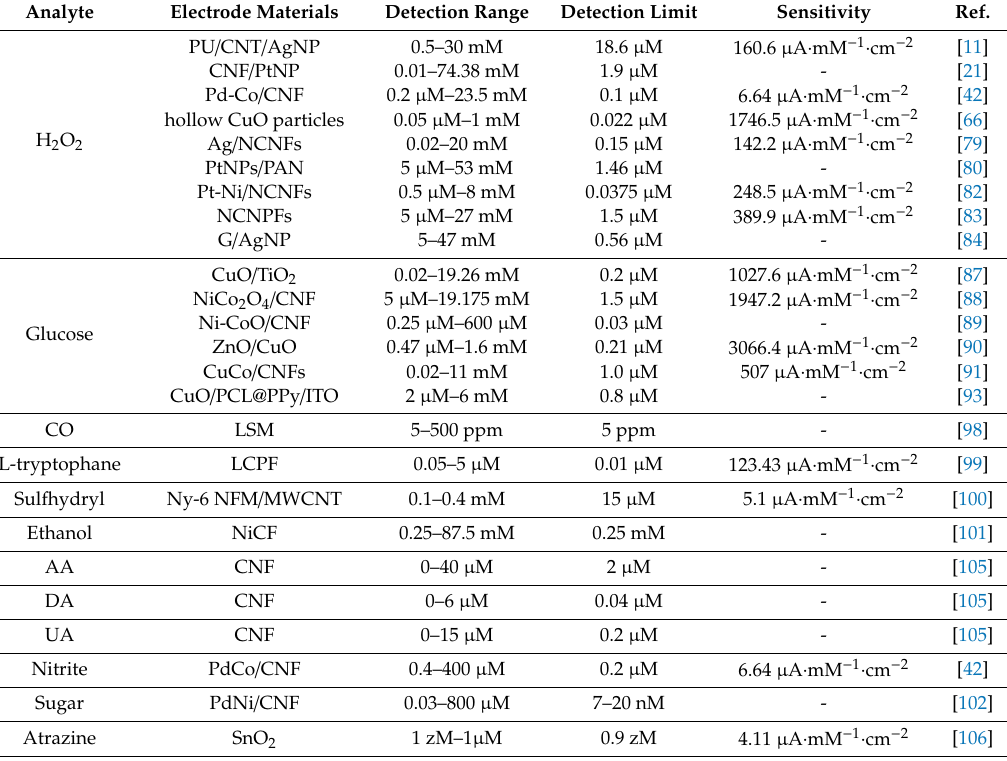
Table 3. Performances of various non-enzyme electrochemical sensors based on